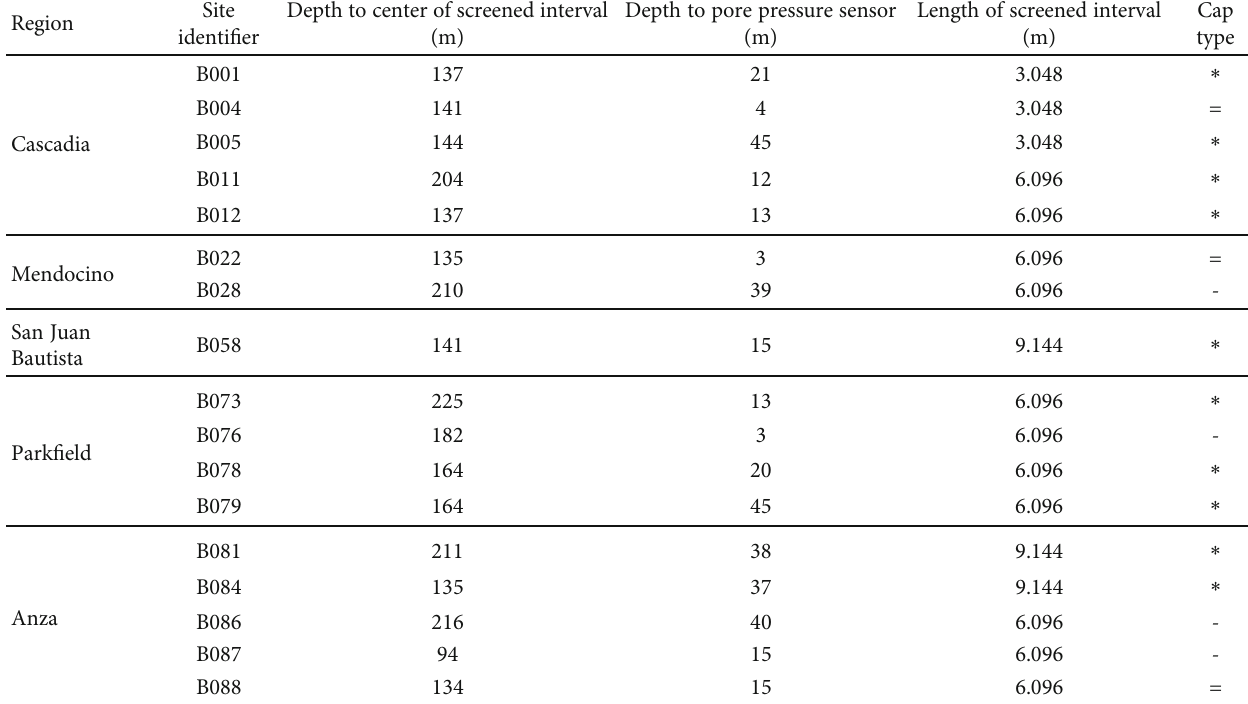
Table 3: Borehole properties. Cap types include a pore pressure packer installed above the pore pressure sensor ( ∗ ) PVC cap at the top of the borehole (=), and no cap or packer (-), indicating the fl uids are open to the atmosphere.